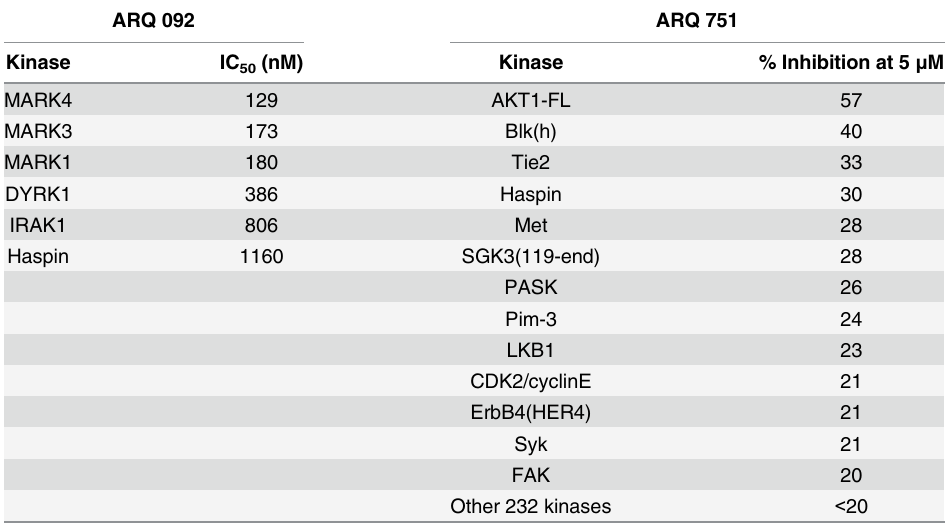
The biochemical IC 50 values of ARQ 092 against 303 kinases were determined (Carna Biosciences). The percent kinase inhibition of ARQ 751 was determined at a concentration of 5 μ M against a panel of 245